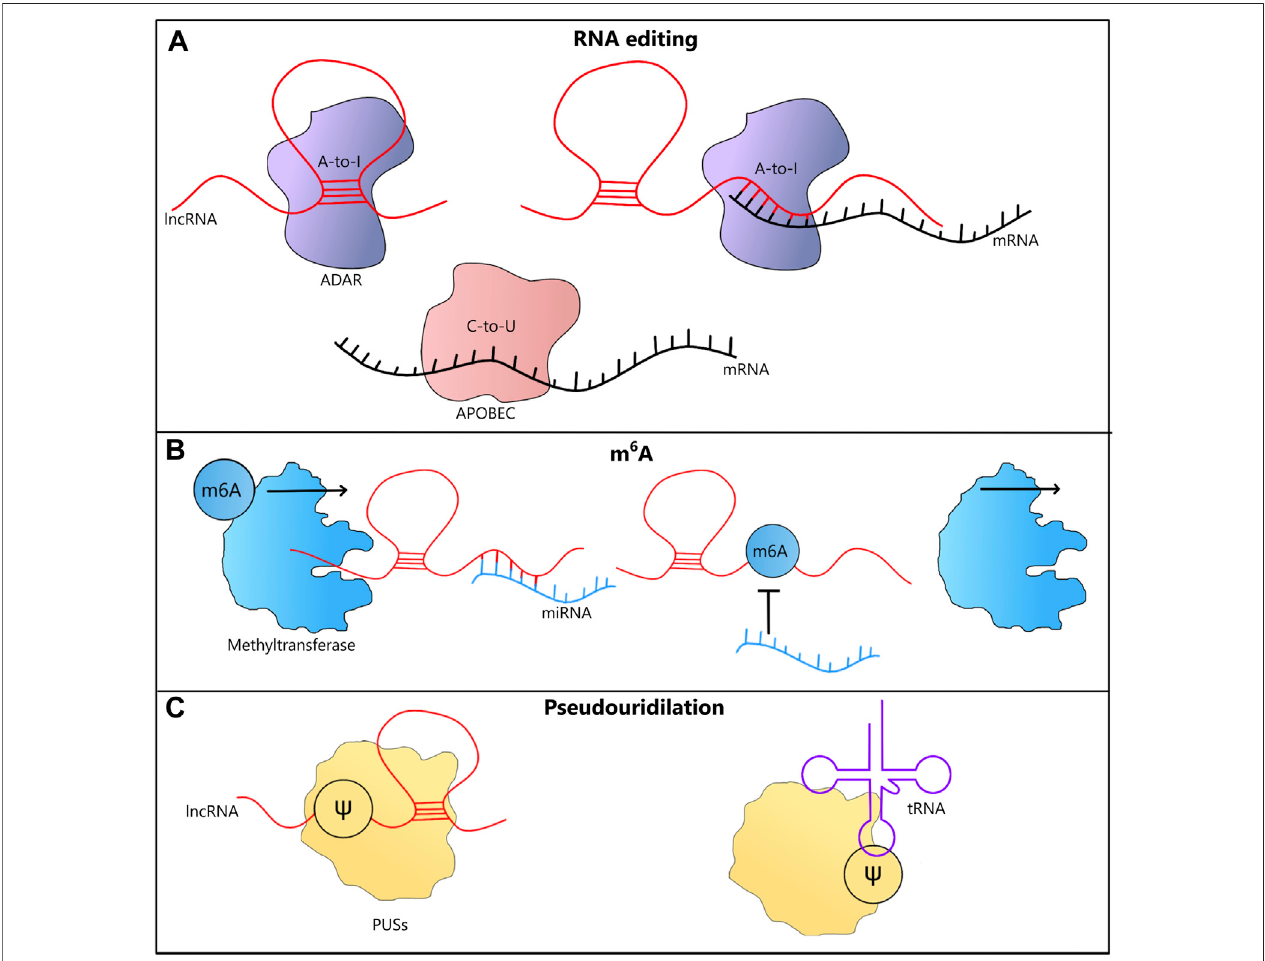
FIGURE 3 | LncRNA-mediated epitranscriptomic modi fi cations. (A) A-to-I RNA editing in lncRNAs, may be triggered by their ability to form dsRNA structures. LncRNAs may also trigger A-to-I RNA editing in mRNAs by coming into direct interactions with them. Both A-to-I and C-to-U RNA editing could affect the coding potential and therefore in fl uence the functions played by proteins. (B) m6A modi fi cation stabilizes RNAs, which is often associated with their increased cellular levels. In case of lncRNAs that act as miRNA sponges, after this type of methylation their functions may be affected, leading to increased levels of miRNAs. (C) Pseudouridilation ( Ѱ ) conducted by PUSs enzymes alters interactions between bases and often leads to changes in the structure of lncRNA and tRNA molecules, affecting their functions.